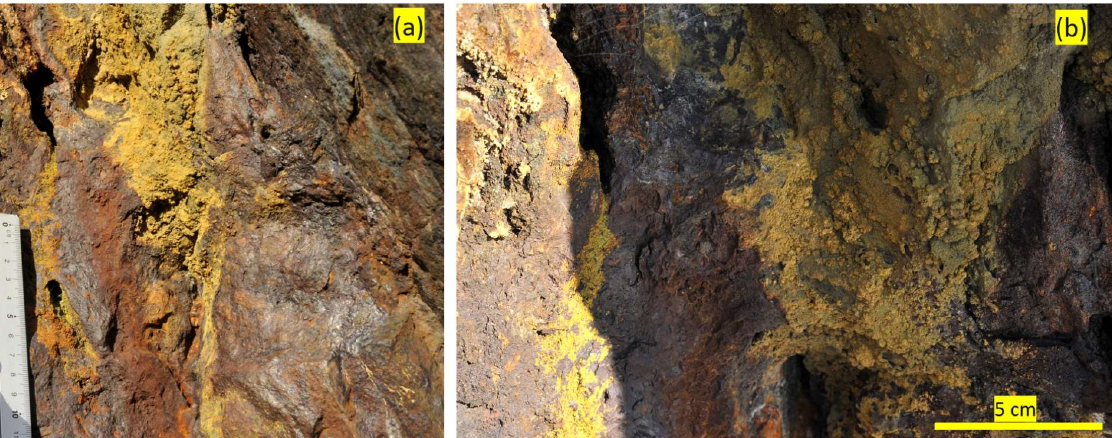
Figure 25. Additional examples of jarosite formations and their weather products in proximity to the holes and cracks in the rock at Stefføya. The image to the right ( b ) is a closer view of one of the holes visible on the rock surface (top left in ( a )). The visible part of the reference ruler length in ( a ) is 11.5 cm long.